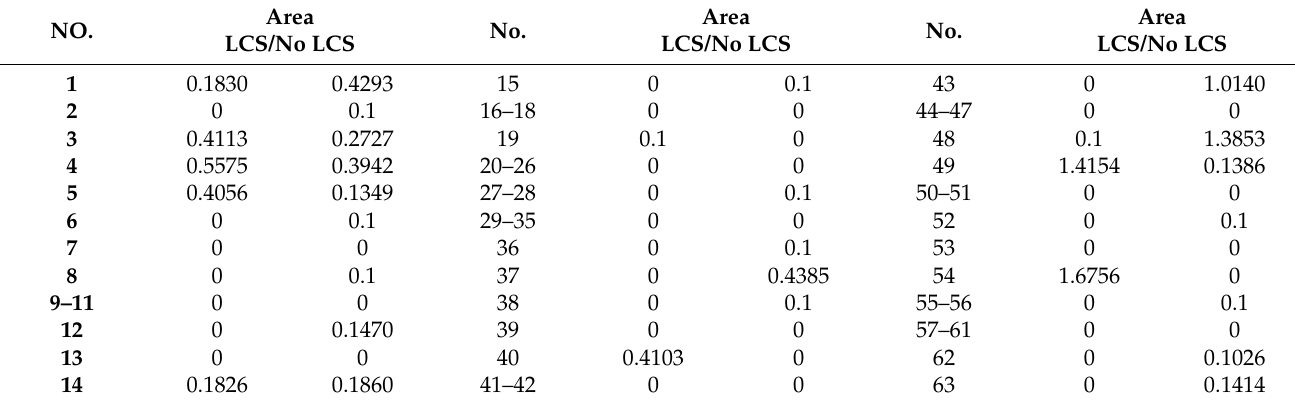
Table 4. Optimal design of the 63-bar